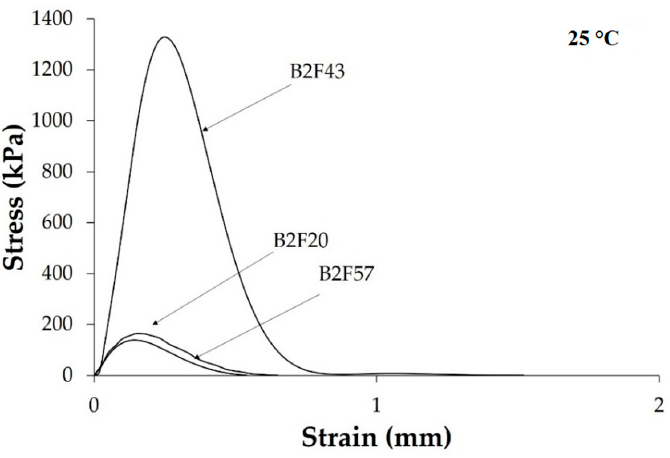
Figure 12. Stress vs. strain curves at 25 °C of some EBA copolymer + ECH resin blends. Table 5. Values of maximum tack, temperature of maximum tack, range of temperature with tack,